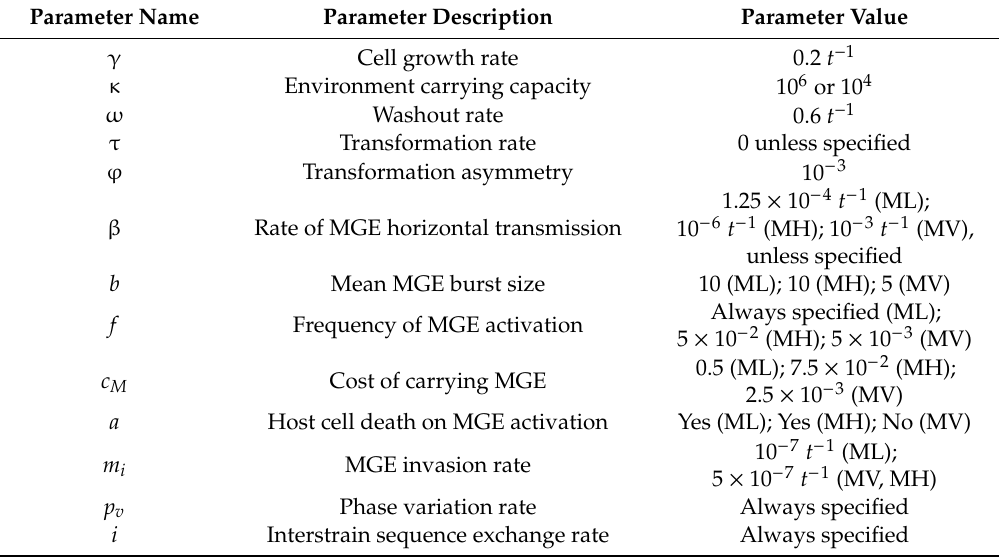
Table 1. Parameters used in simulations. Parameters relating to mobile genetic elements (MGEs) are specified for the lysogenic phage-type MGE (ML), the integrative MGE with a greater propensity for horizontal transmission (MH), and the integrative MGE with a greater propensity for vertical transmission (MV). The unit t is a timestep in the